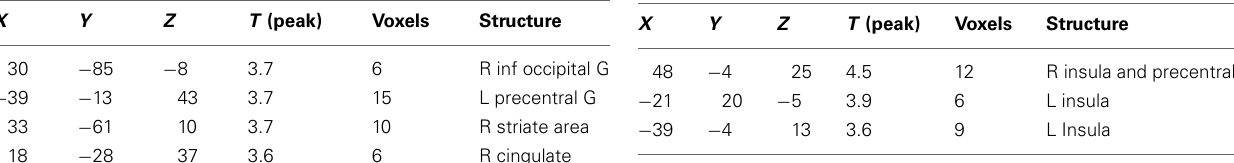
Table 4 | Brain activation due to ambroxan within a mixture in ambroxan sensitive subjects; contrast: SEN: MIX + AMB vs. MIX (masked ALL vs. CON) ( p < 0 . 001; uncorrected).